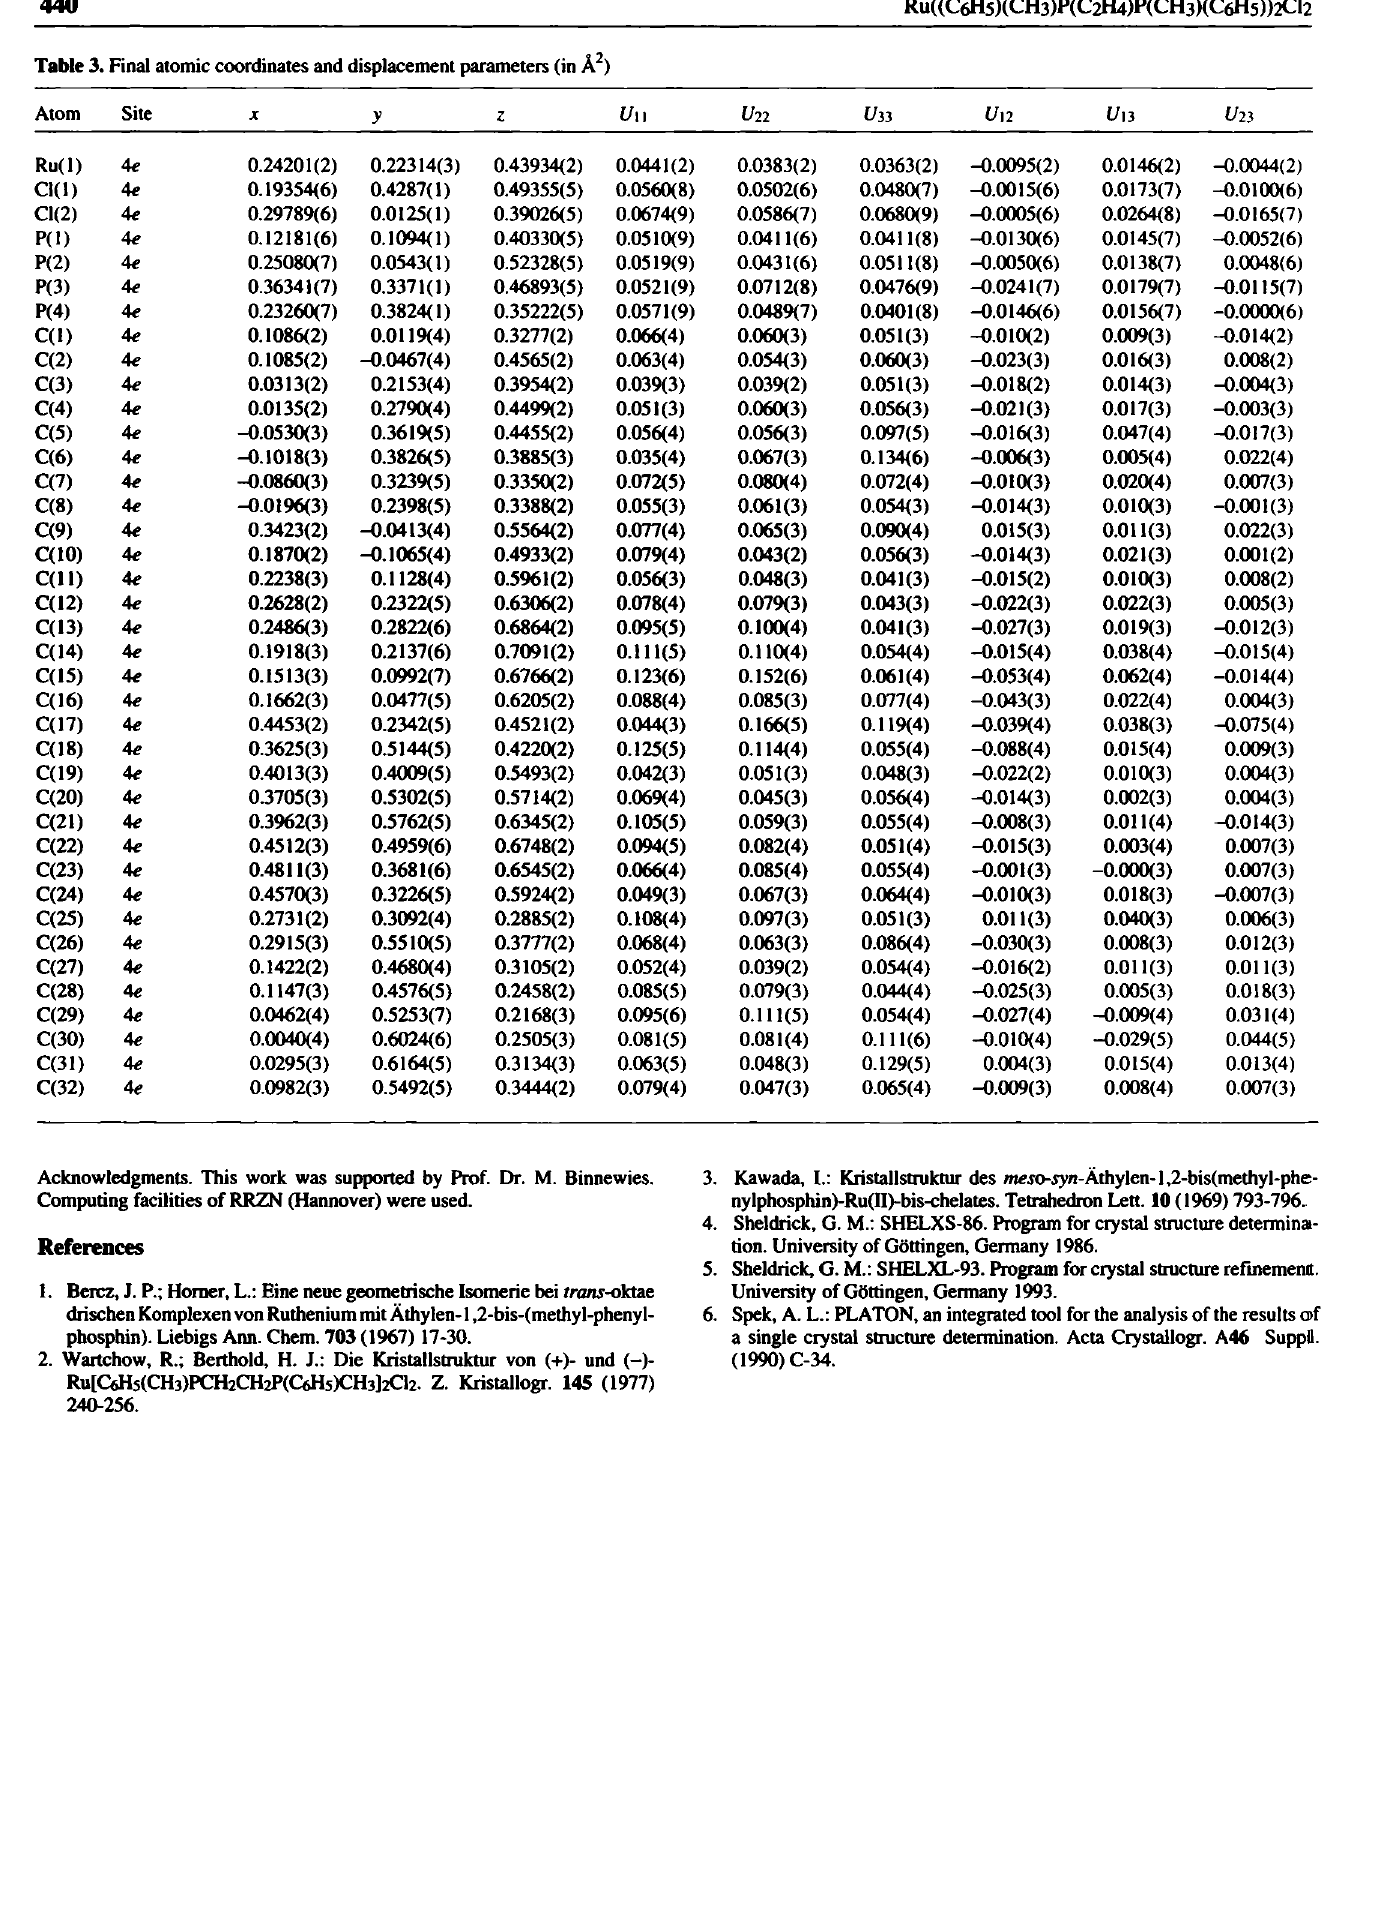
Table 3. Final atomic coordinates and displacement parameters (in Â 2 )